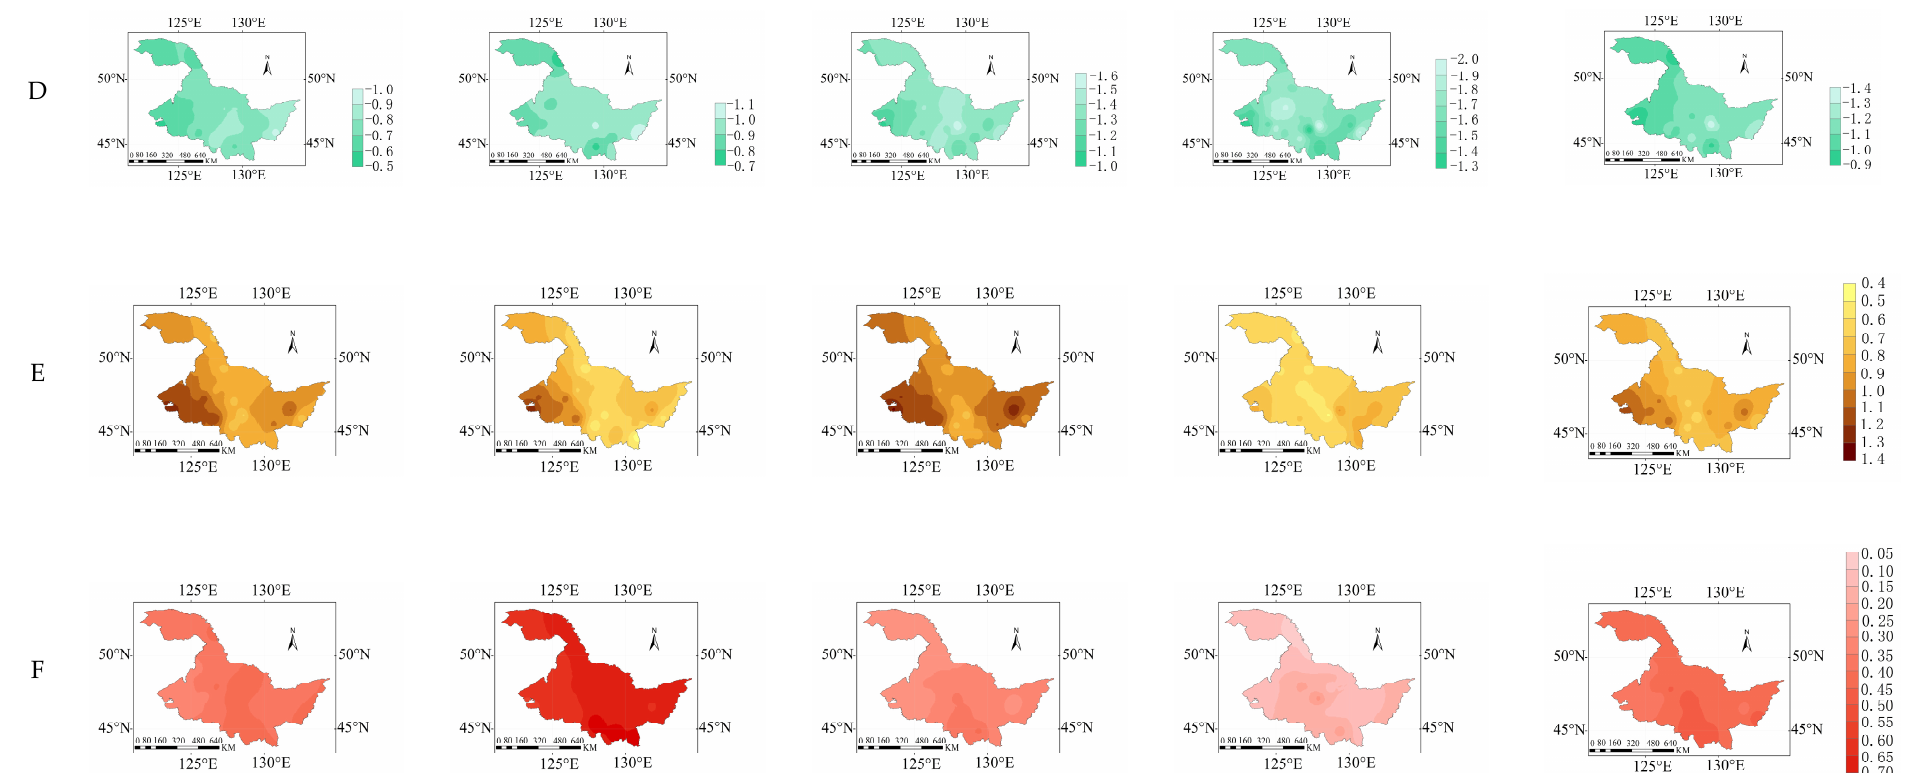
Figure 6. Spatial distribution of sensitivity coefficients of ET 0 to ( Row A ) T max, ( Row B ) T min, ( Row C ) T mean, ( Row D ) RH , ( Row E ) U , ( Row F ) Rn from 1960 to 2019.